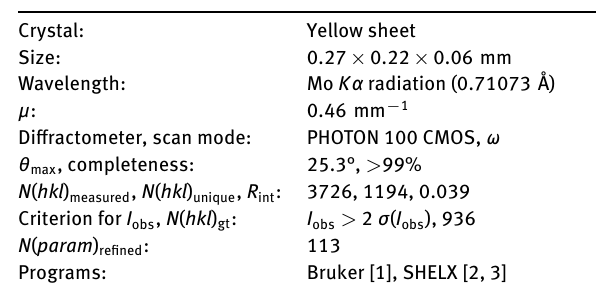
Table 1: Data collection and handling.